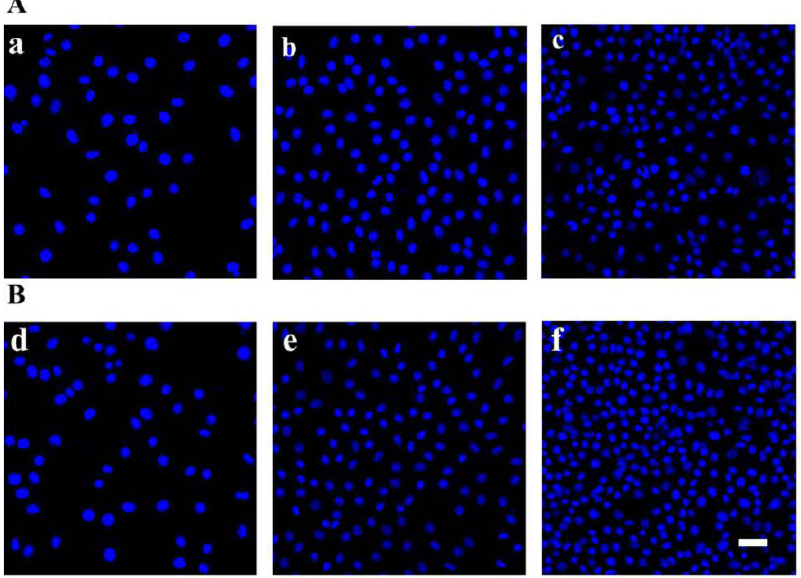
Figure 5. ( A ) Fluorescence microscopy of L929 cells adhered to the PLA membranes on days ( a ) 1, ( b ) 3, and ( c ) 7. ( B ) Fluorescence microscopy of L929 cells adhered to the PLA/PVA/SA membranes on days ( d ) 1, ( e ) 3, and ( f ) 7.